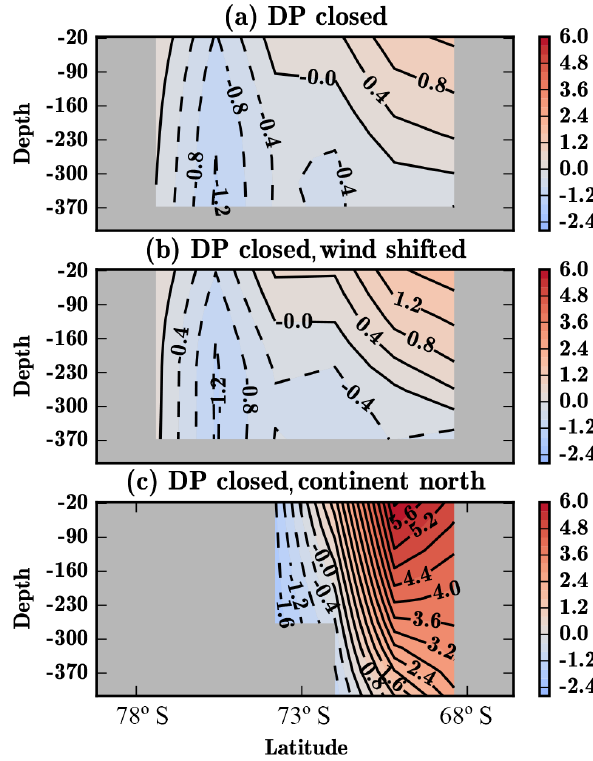
Figure 1. Meridional section of zonal velocity u (cms − 1 ) inside the Tasman Gateway with the Drake Passage closed for (a) the stan- dard simulation, (b) the Southern Hemisphere westerlies shifted 6 ◦ northward, and (c) Australia and the Antarctic margin in a more northward position. All locations are well south of the latitudes of zero wind stress curl. Positive values indicate eastward flow; nega- tive values indicate westward